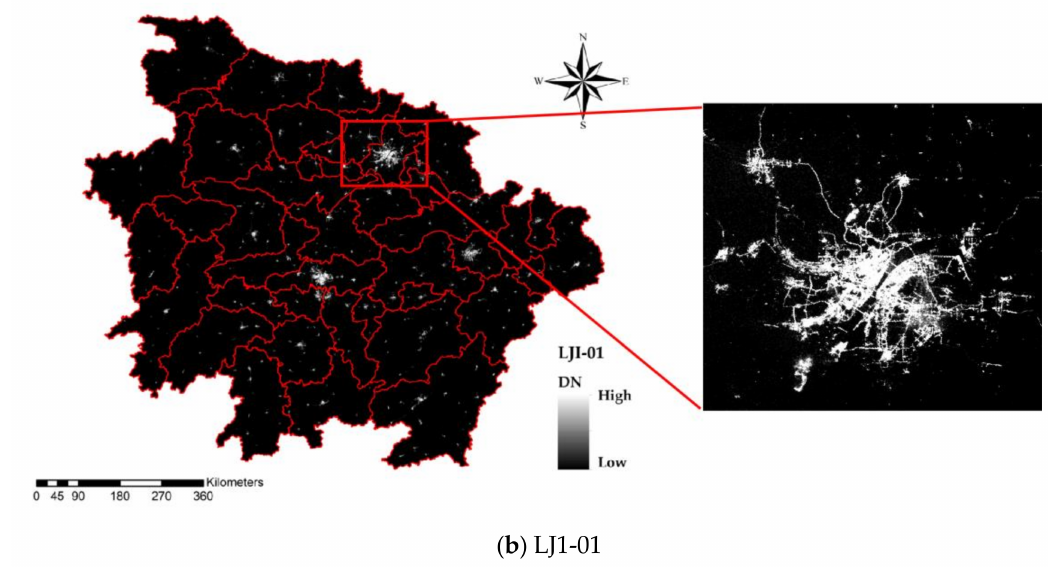
Figure 3. Processed NTL data of the study area. The red rectangle outlines the Wuhan urban area. ( a ) Processed NPP / VIIRS NTL data in 2018 and ( b ) processed LJ1-01 NTL data in